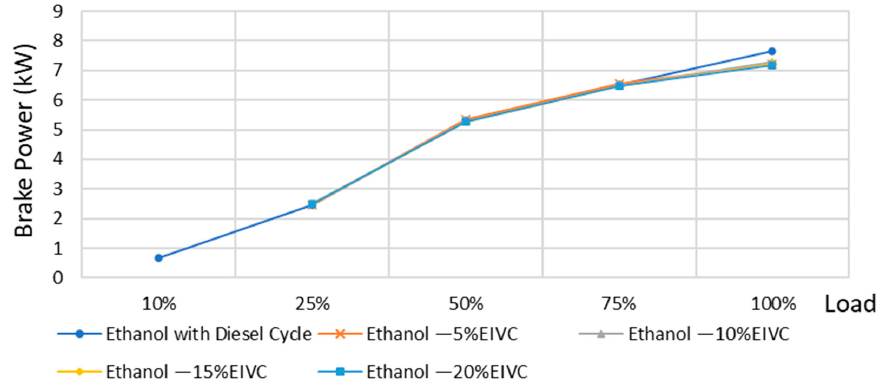
Figure 15. BP(kW) of ethanol engine with EIVC Miller Cycle.